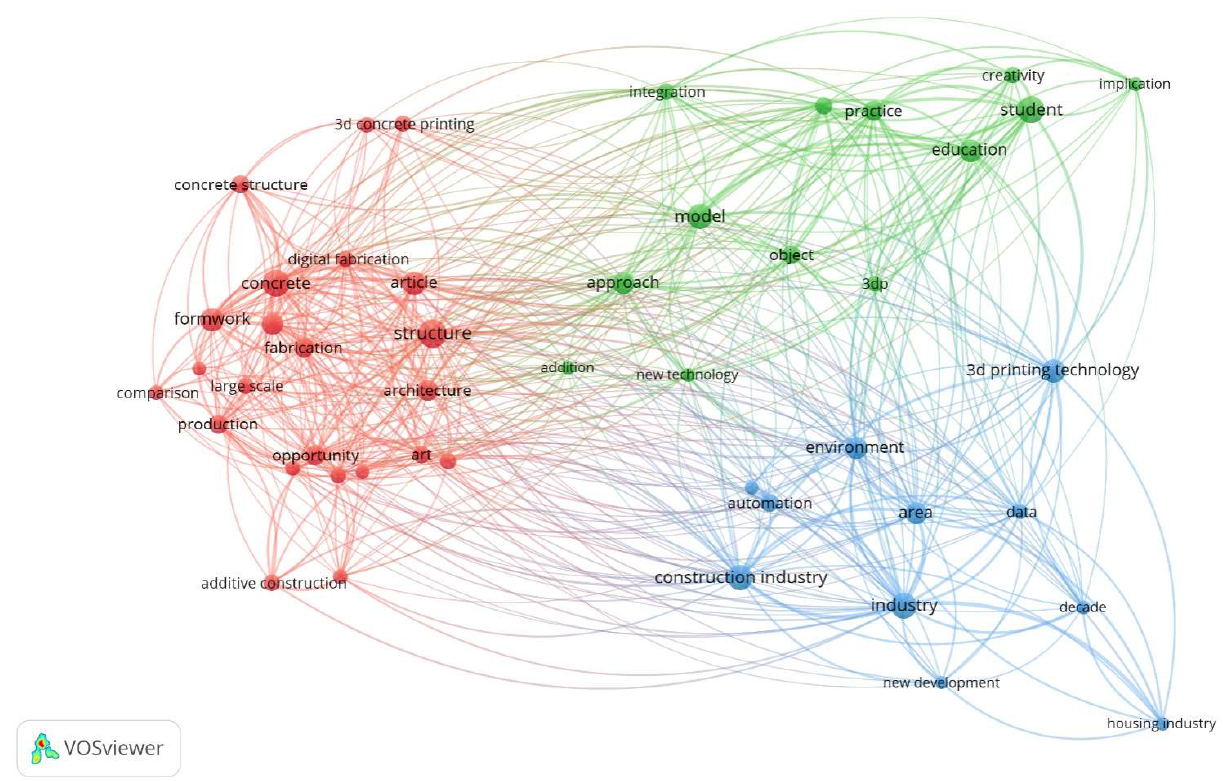
Figure 3. Network visualization of occurrence of keywords and clusters in the analyzed literature sample.